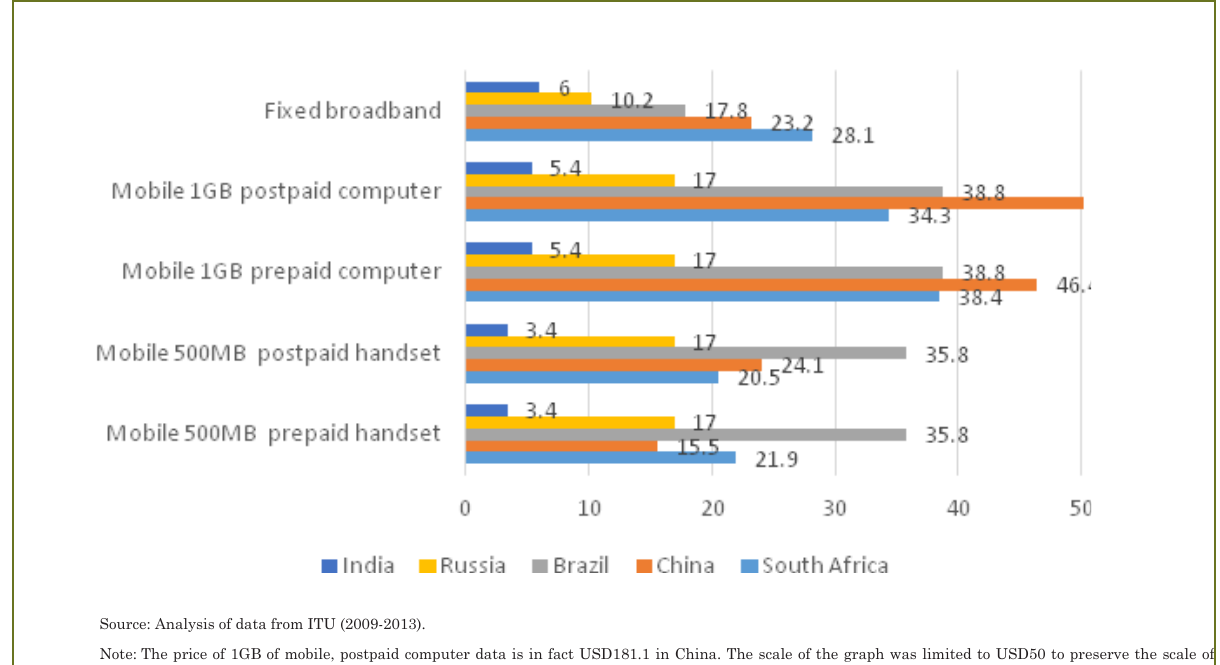
Source: Analysis of data from ITU